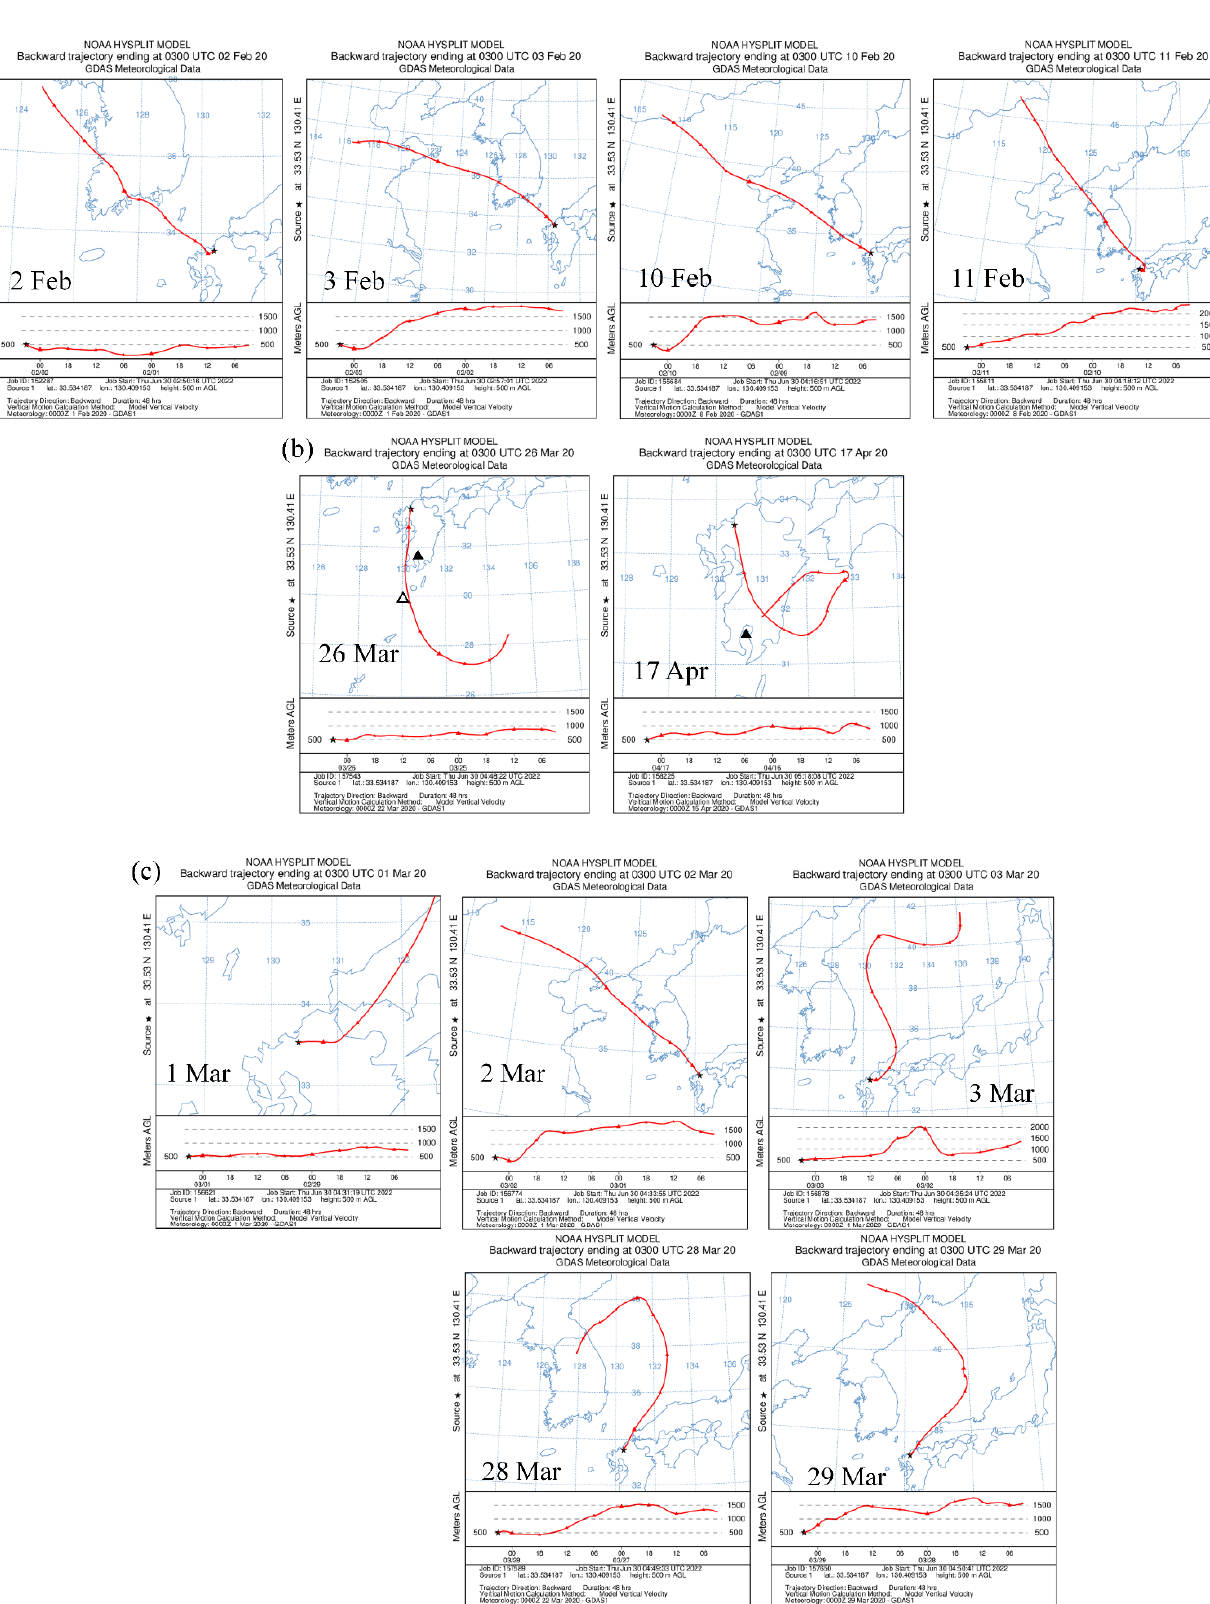
Figure 5. Backward trajectories of high concentration days for PM 2 . 5 , sulfate, and total PAHs. ( a ) February 2–3, and 10–11. ( b ) March 26 and April 17. Closed triangle: Sakurajima, open triangle: Suwanosejima. ( c ) March 1–3 and 28–29.